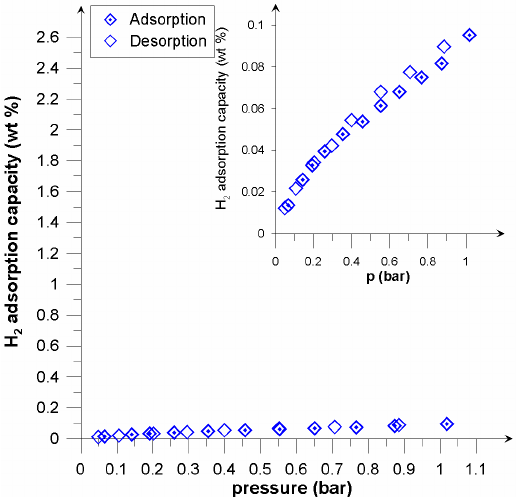
Figure 7. Adsorption/desorption isotherms of hydrogen on Picazine K at 300 K.